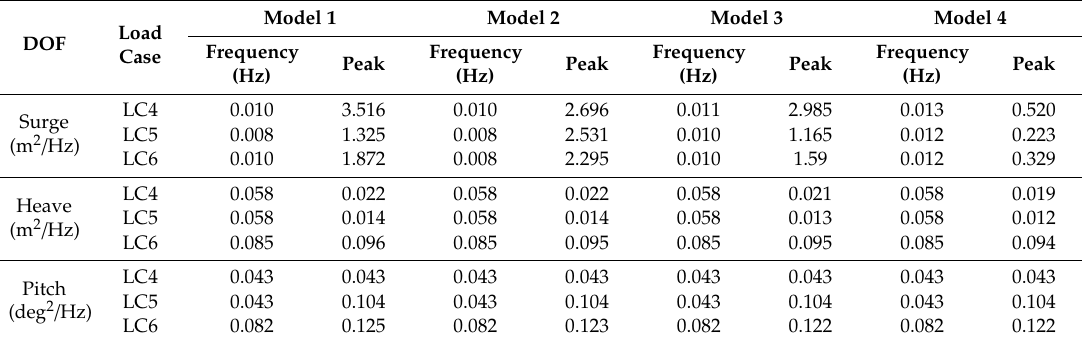
Table 11. Surge, heave, and pitch PSDs of the multi-segmented mooring line models in the frequency domain.